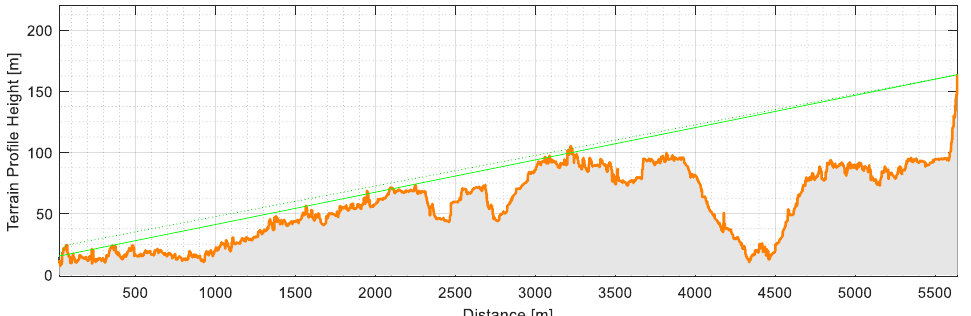
Figure 11. Distance profile between the waste container at Belém and the LoRa gateway at Amoreiras.